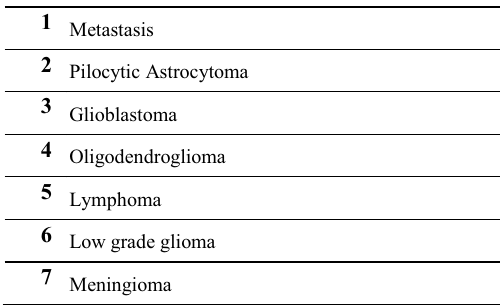
Table1. Brain tumors constituting the study framework.